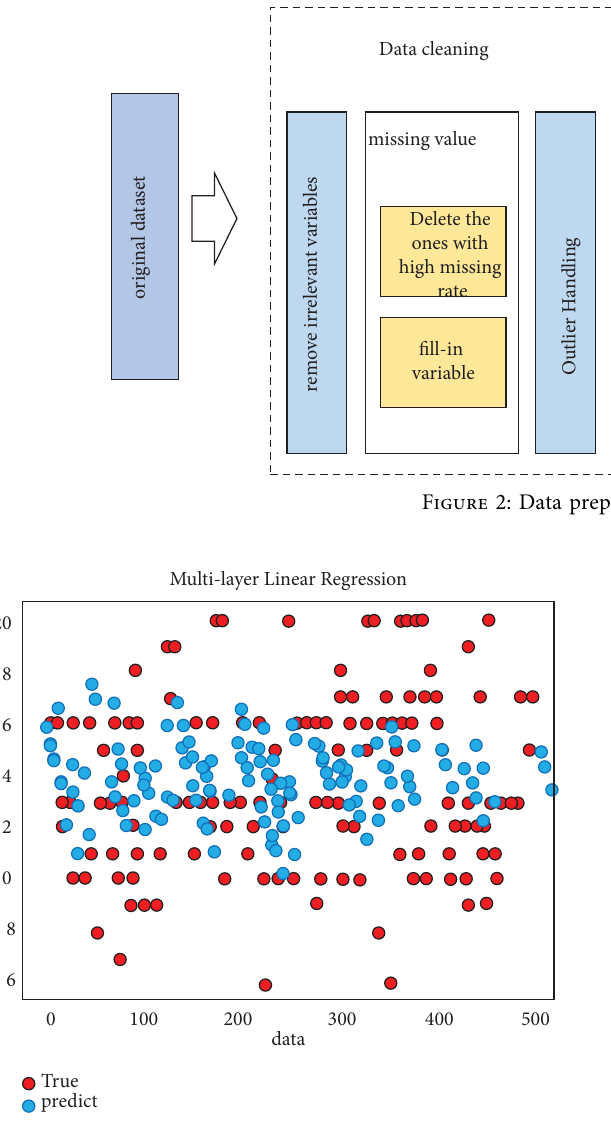
Figure 3: Multilayer linear regression test set ftting results. Figure 4: Regression curve of the multilayer linear regression